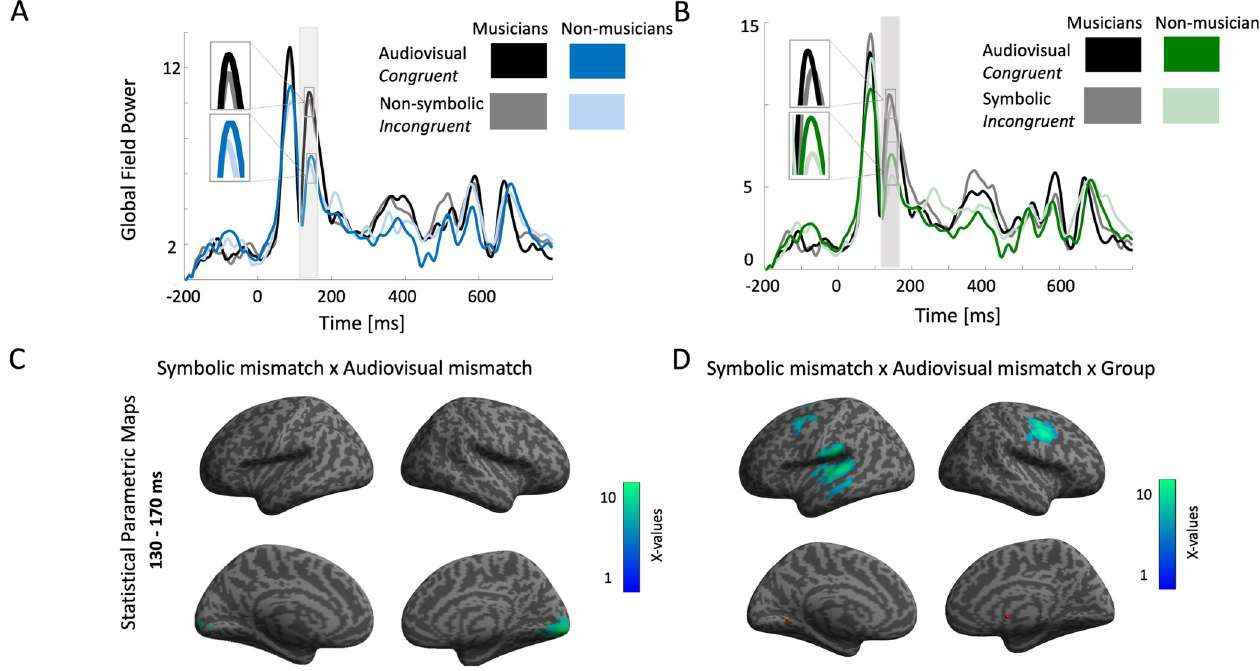
Fig 3. Audiovisual non-symbolic and symbolic interaction in musicians and non-musicians. A: Grand average of global field power for musicians and non- musicians during the presentation of audiovisual congruent and audiovisual (non-symbolic) incongruent stimuli. Shaded area depicts the predefined window of analysis (130–170 ms). B: Grand average of global field power for musicians and non-musicians during the presentation of audiovisual congruent and audiovisual symbolic incongruent stimuli. Shaded area depicts the predefined window of analysis (130–170 ms). C: Statistical Parametric Maps for the interaction of audiovisual non-symbolic and symbolic mismatch response generators. Threshold p < 0.005, cluster corrected. D: Statistical Parametric Maps for the interaction of audiovisual non-symbolic mismatch × symbolic mismatch × group. Threshold p < 0.05, cluster corrected.